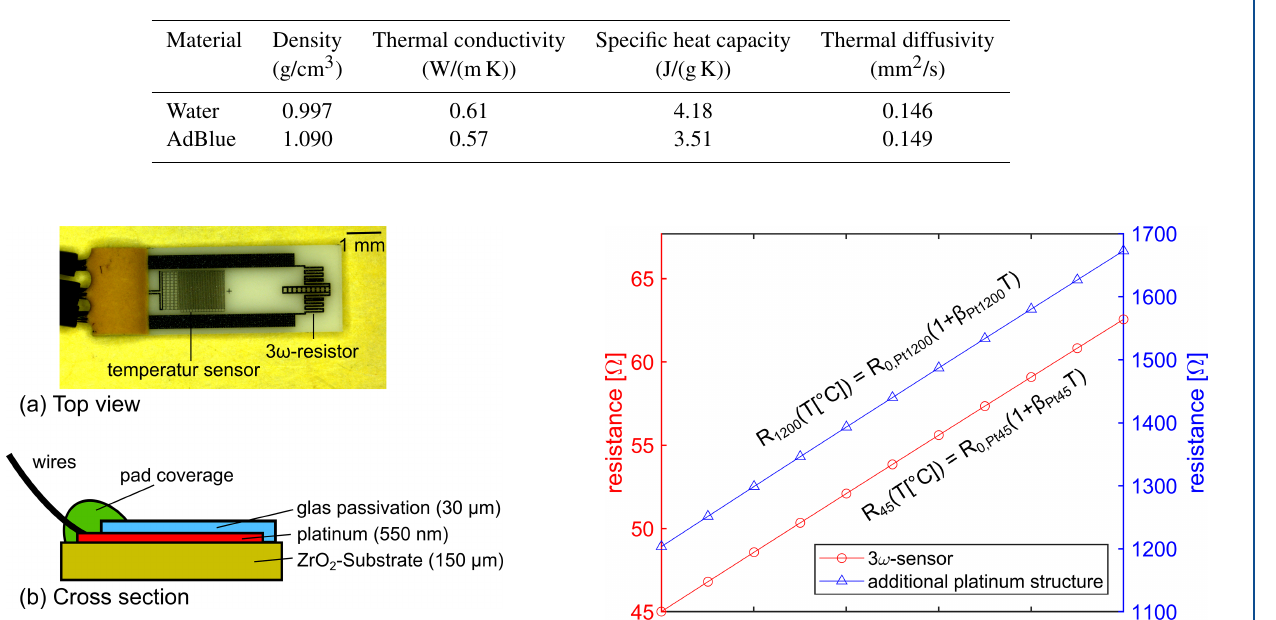
Table 1. Thermal characteristics of water and AdBlue at 25 ◦ C (Care, 2009; BASF – The Chemical Company, 2006).